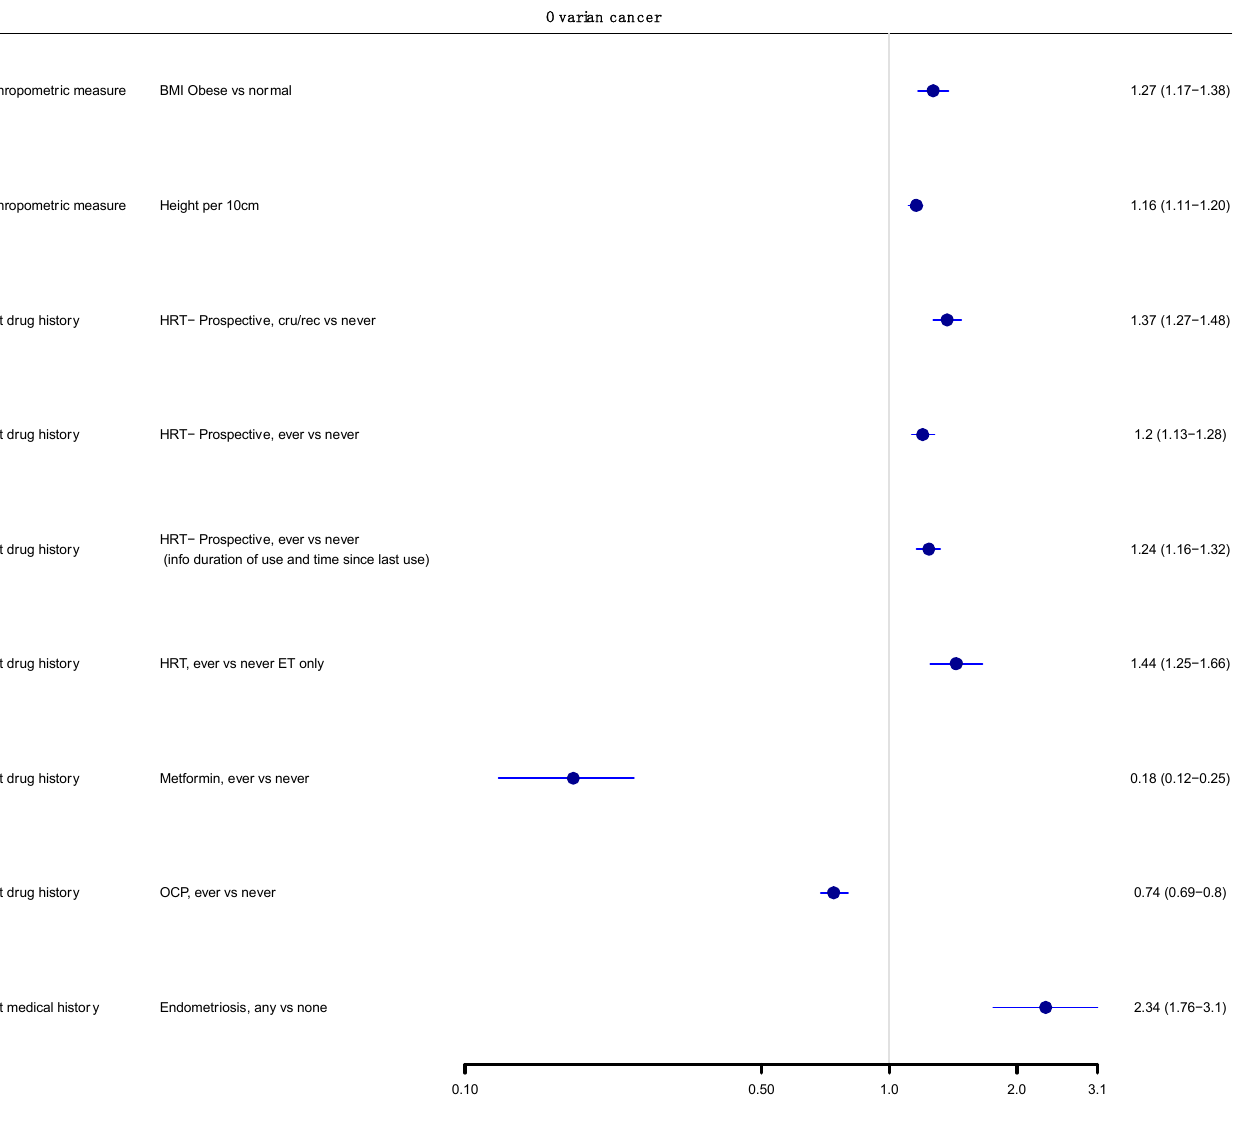
Figure 3. Main analysis results (cohorts only, summary random effects). Forest plot of strong and highly suggestive evidence of an association with ovarian cancer.